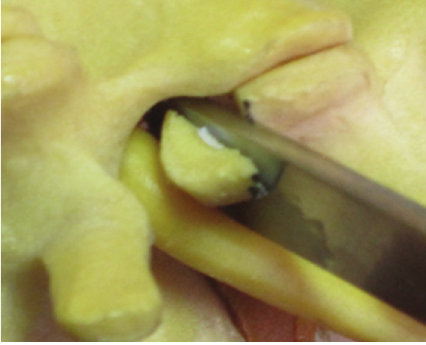
Figure 2: Planned partial resection of the upgoing facet.